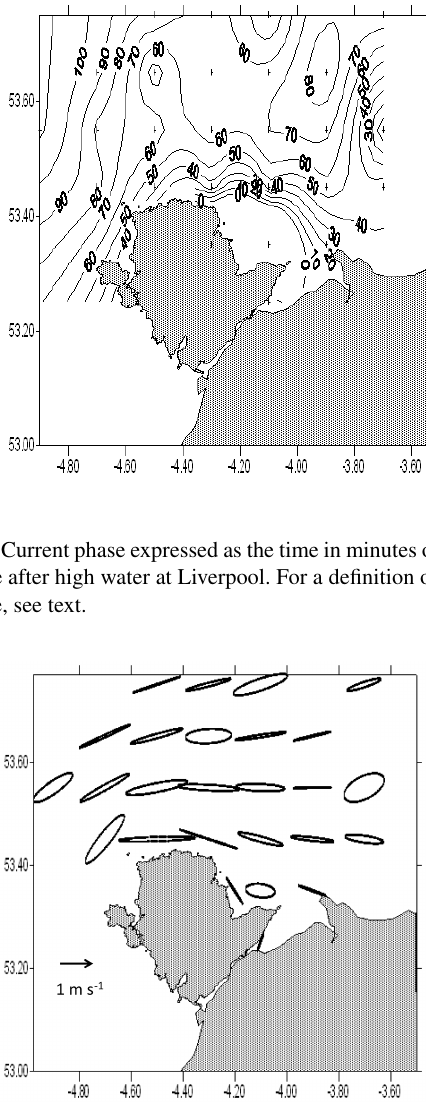
Figure 6. Tidal current ellipses derived from bird tracks. Each el- lipse shows the path traced out by the current vector at mean tide about a point at the centre of each of the boxes used in the analy- sis. The scale is shown by the arrow. In most cases the current turns within the ellipse in a clockwise